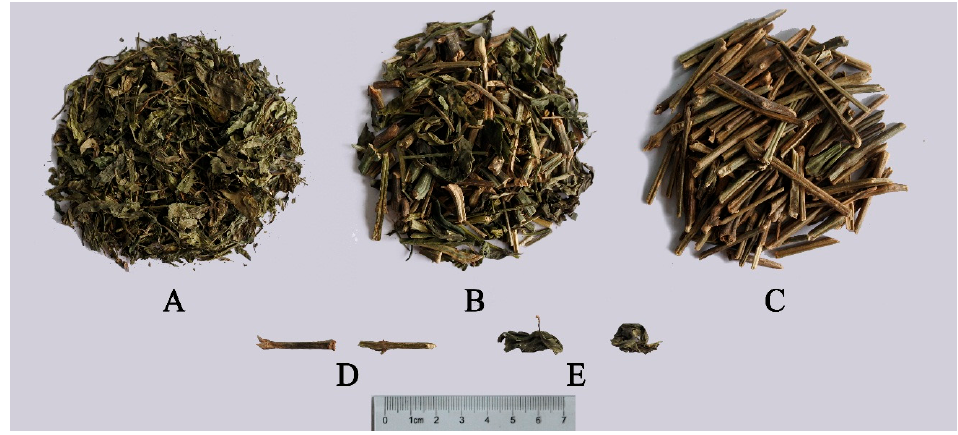
Figure 5. Three typical AH samples with different specification. A : leaf sample; B : a mixture of leaf and stem sample; C : stem sample; D : stem; E :